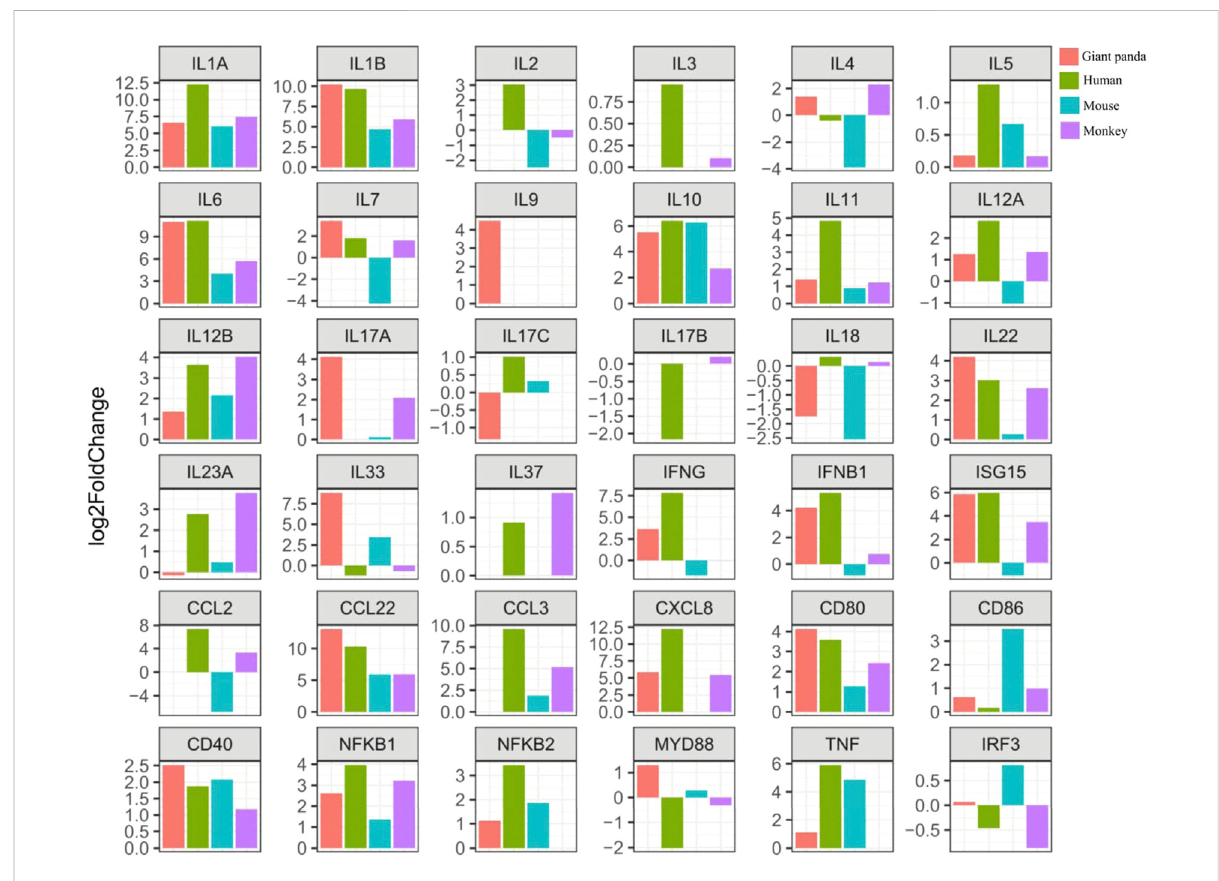
FIGURE 5 Expression tendency of selected gene expression among giant pandas, humans, mice, and